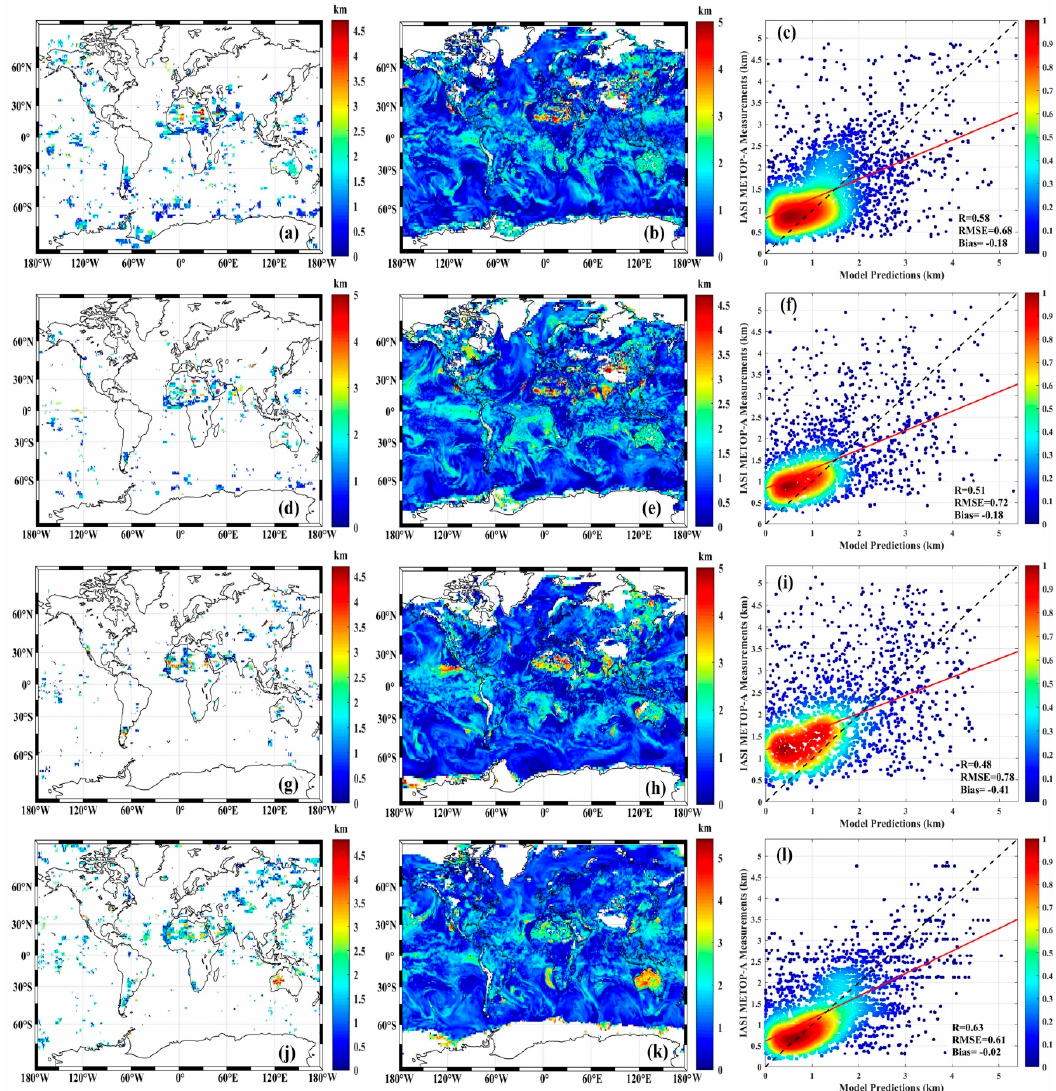
Figure 15. The validations on daily dust aerosol MFA predictions. ( a ), ( d ), ( g ) and ( j ) are the results for dust aerosol layer height observed by IASI on 1st January 2019, 1st April 2019, 1st June 2019, and 1st October 2019, respectively. ( b ), ( e ), ( h ), ( k ) are the model predicted dust aerosol MFA on 1st January 2019, 1st April 2019, 1st June 2019, and 1st October 2019, respectively. ( c ), ( f ), ( i ) and ( l ) are the scattering density plots comparisons of the dust aerosol MFA between model predicted and IASI observed values on 1st January 2019, 1st April 2019, 1st June 2019, and 1st October 2019, respectively.